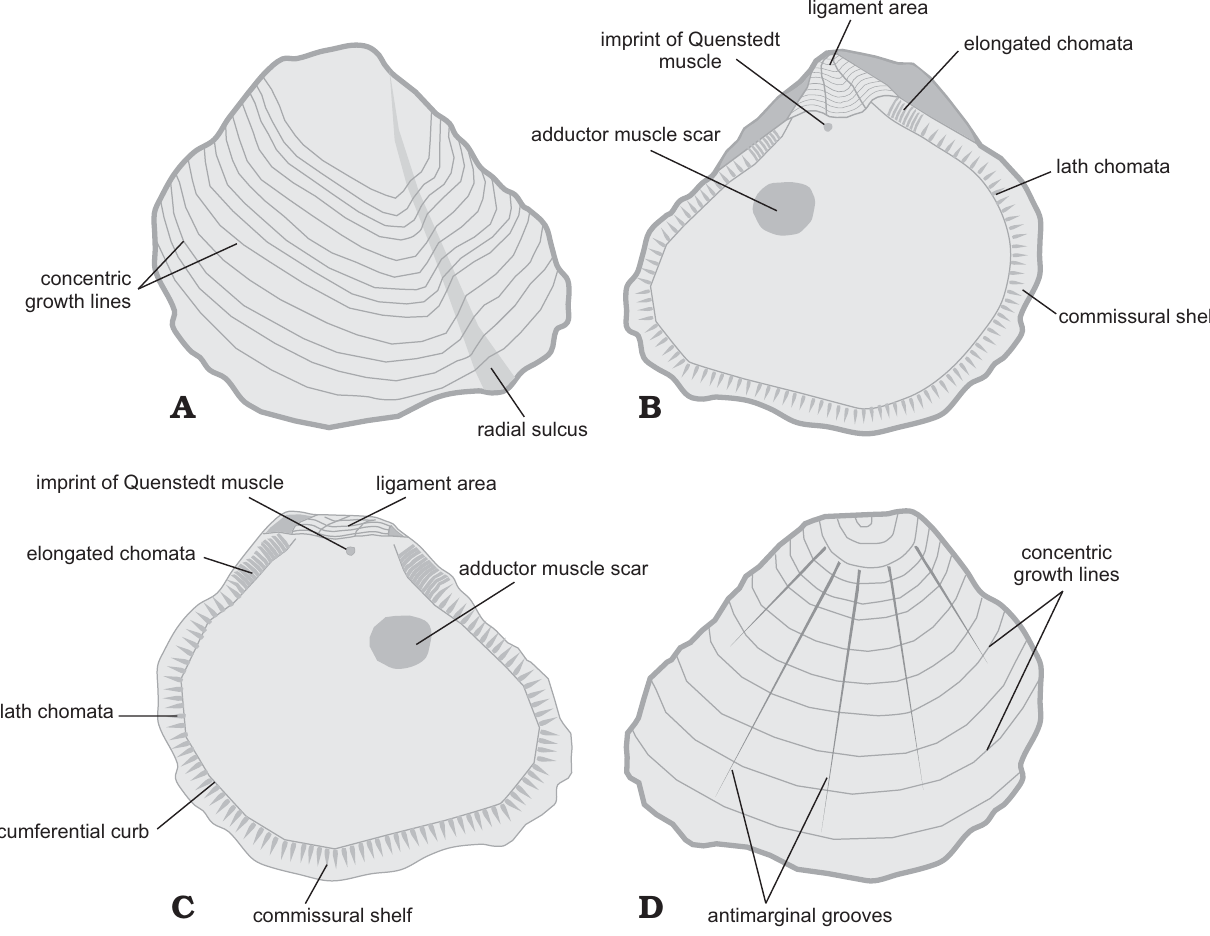
Fig. 1. Schematic drawing illustrating shell morphology of Pycnogryphaea weberae Yanin in Tschelzova, 1969. Left valve in inner ( A ) and outer ( B ) views; right valve in inner ( C ) and outer ( D ) views. The image is given approximately in natural